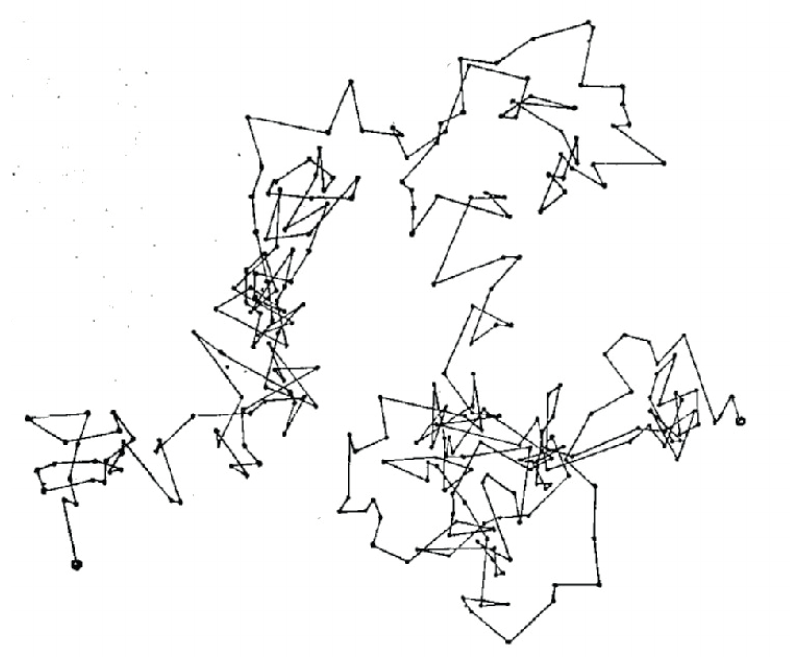
Figur 1. Illustration av Brownsk rörelse, rapporterad av Perrin, i ultramikro skop för mastixpartiklar (ca 0,5 μm) uppslammade i vatten. Tidsmellanrummet mellan två mätningar är 1/3 sekund. Avstånd mellan punkterna för resans början till slut är 0,035 μm. Med tätare mätintervall visar det sig att rörelserna mellan två mätpunkter är lika komplicerade som hela figuren. Från Jean Baptiste Perrin, Les Atoms, Libraire Félix , Paris 1927 – sid